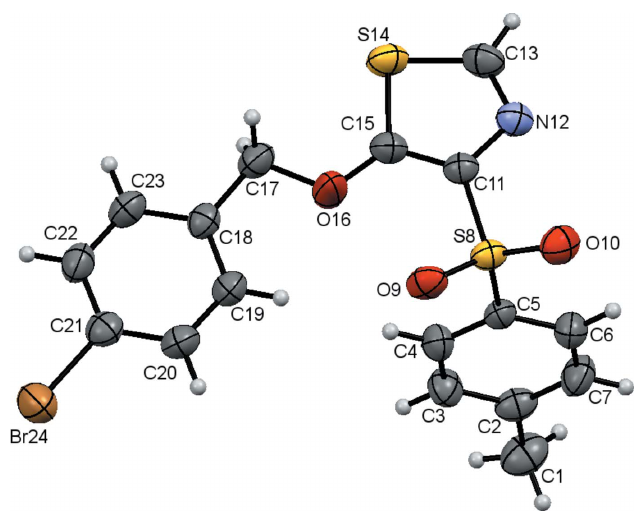
Figure 1 The molecular structure with 50% probability displacement